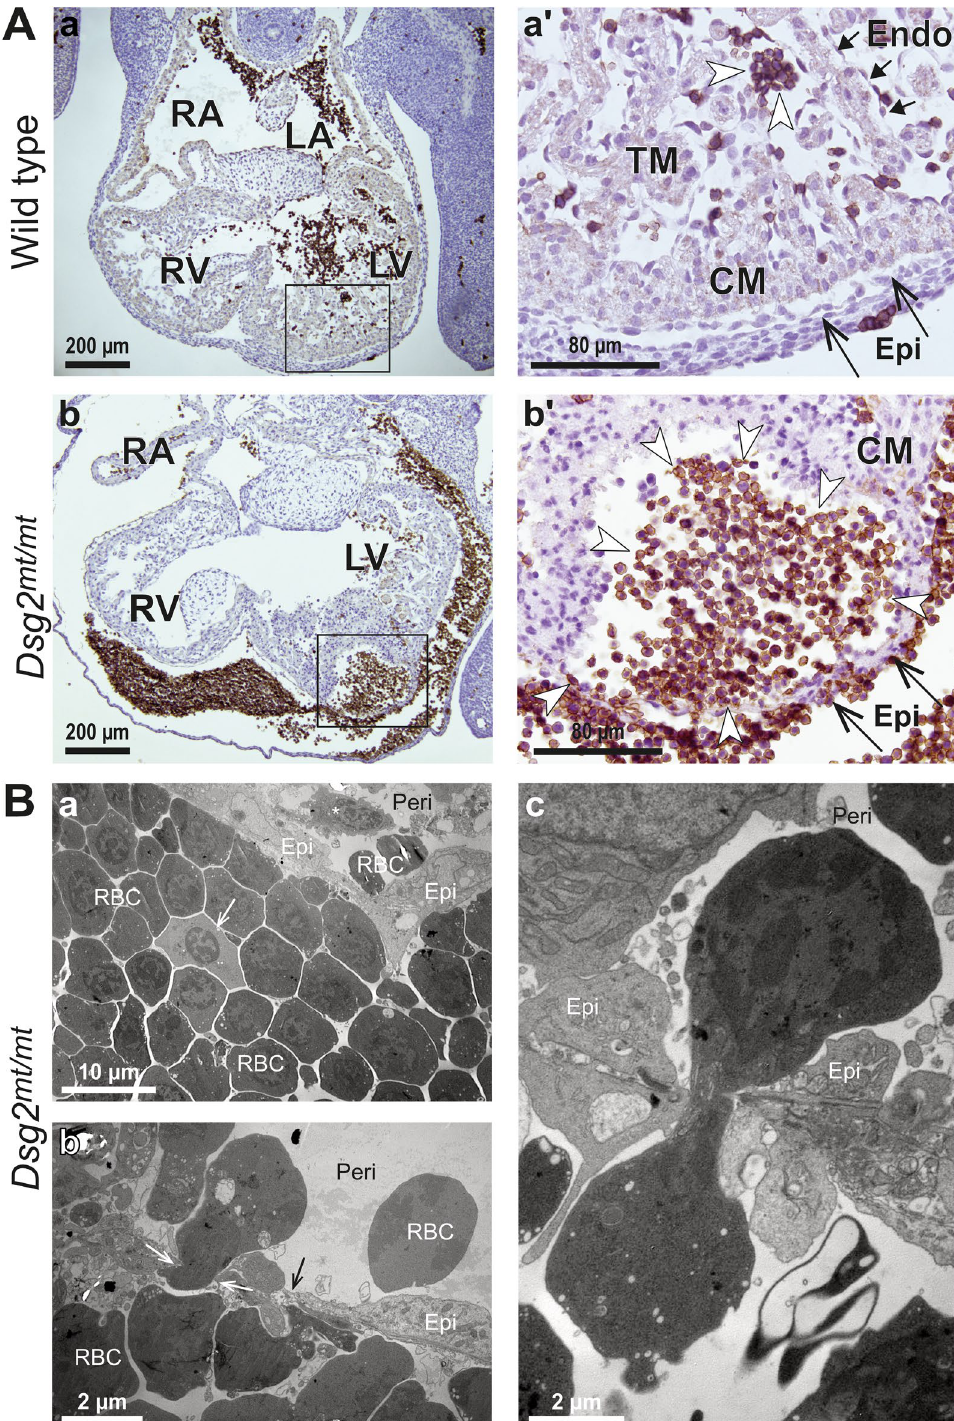
Figure 2. Expansion of erythrocytes in Dsg2 mt/mt hearts. ( A ) Immunohistochemical Ter119 staining shows that type B cell clusters in Dsg2 mt/mt hearts consist of differentiating erythrocytes (n = 3 hearts per group). The picture pairs depict E11.5 heart sections prepared from a wild-type ( a – a ʹ ) and a Dsg2 mt/mt embryo ( b – b ʹ ) at low and higher magnification (boxed areas). Note that only circulating erythrocytes are Ter119 + in the wild-type heart (brown; white arrowheads in a ʹ ) whereas a large subepicardial accumulation of abnormal cells is strongly Ter119 + in the Dsg2 mt/mt heart (white arrowheads in b ʹ ). The mutant heart also contains aberrant Ter119 + cells in the pericardial space. RA, right atrium; LA, left atrium; RV, right ventricle; LV, left ventricle; Endo, endocardium (short arrows); Epi, epicardium (long arrows). Size bars: 200 µm in ( a,b ); 80 µm in ( a ʹ , b ʹ ). ( B ) Electron microscopy reveals that differentiating erythrocytes migrate into the pericardial cavity in the heart of an E11.5 Dsg2 mt/mt embryo. ( a ) Shows red blood cells (RBC) surrounding an undifferentiated pale cell (arrow) in a type B cell cluster that is directly adjacent to the epicardial cell layer (Epi). Note that a migrating cell (*) and red blood cells (RBC) are detected in the pericardial space (Peri). ( b , c ) The higher magnification images show aspects of red blood cell migration through the epicardium into the pericardial space (same abbreviations as in a ). Note, how red blood cells squeeze through narrow gaps (e.g., white arrows in b ). The black arrow demarcates a thinned epicardial cell that will likely be penetrated by the adjacent deformed red blood cell. Size bars: 10 μm in ( a ), 2 μm in ( b , c